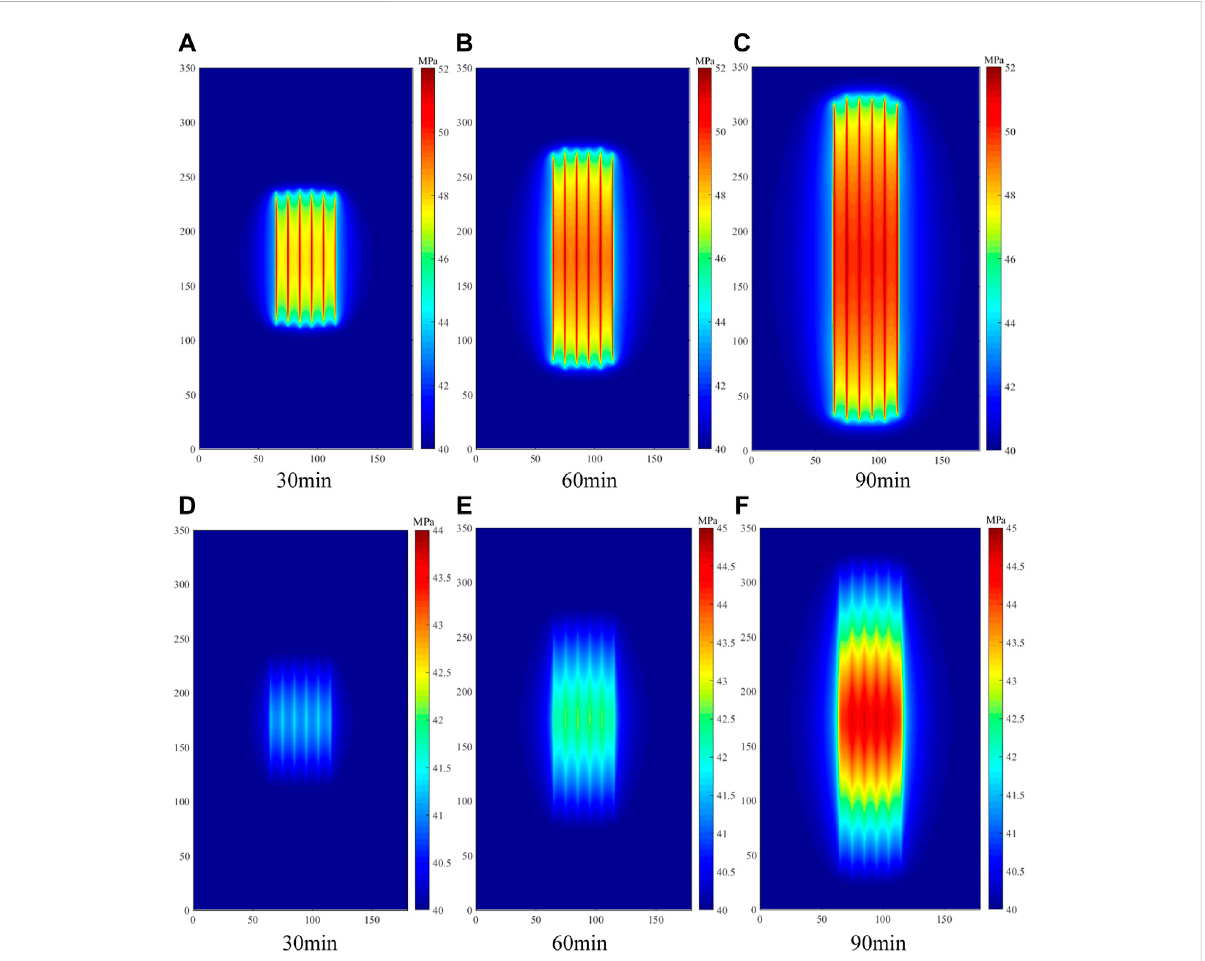
FIGURE 5 Distribution of pressure in the micro-fracture system and matrix during fracture propagation. (In (A – C) , the range of pressure in the micro- fracture system is from 40 to 52 MPa. In (D) , the range of pressure in matrix is from 40 to 44 MPa. In (E,F) , the range of pressure in the matrix is from 40 to 45